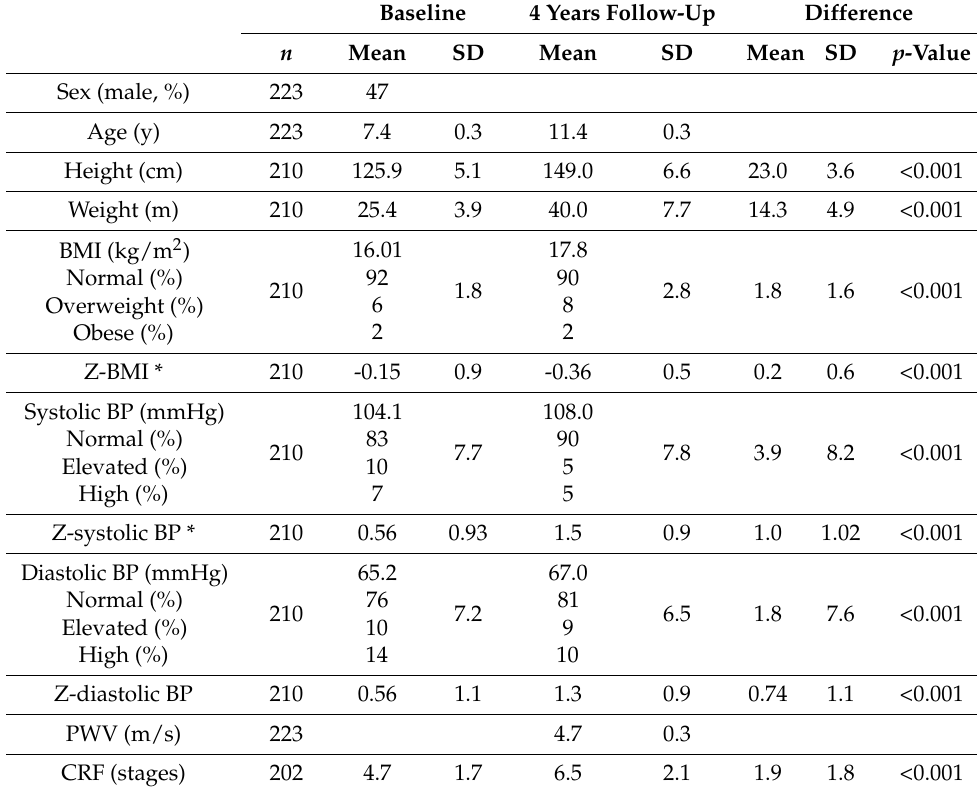
Table 1. Population characteristics.